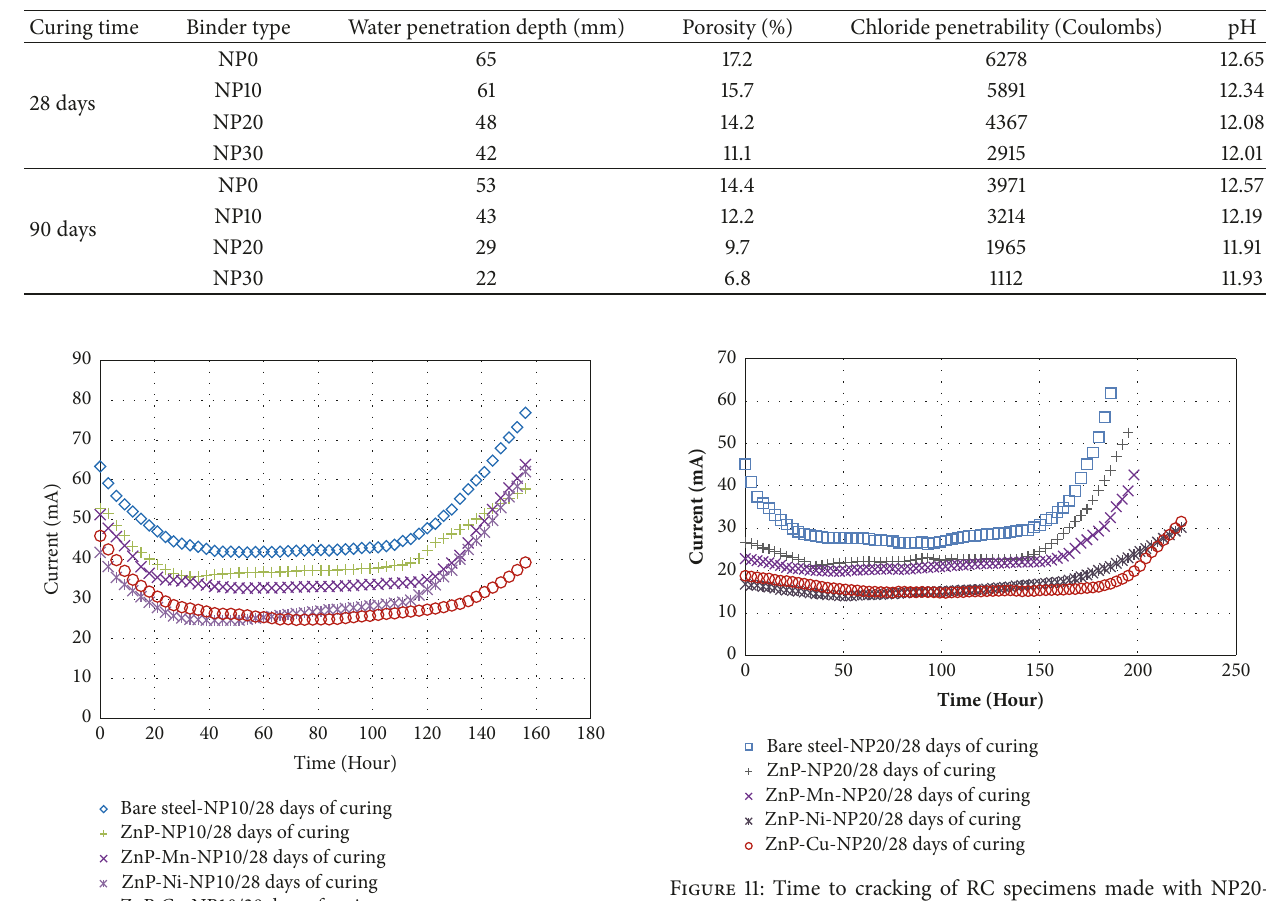
Table 4: Water penetration depths, porosity, chloride penetrability, and pH of the investigated concrete.